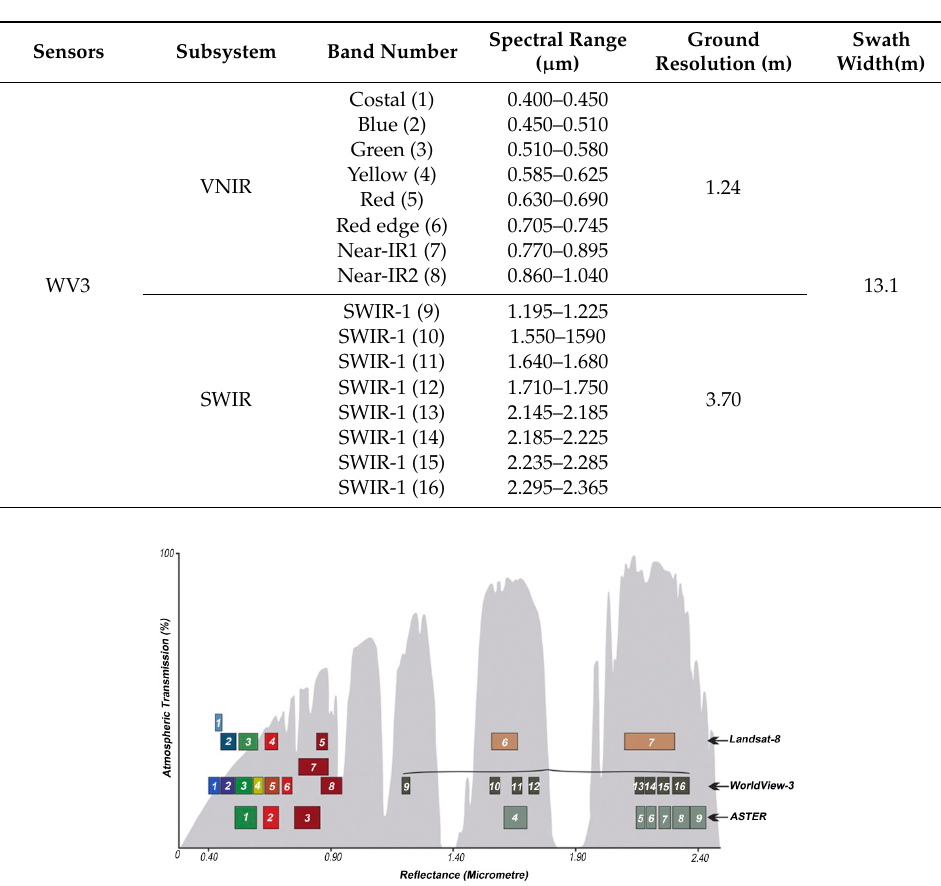
Figure 2. Comparison of the spectral bands of WV-3 with Landsat-8 and ASTER in the visible and near-infrared (VNIR) and shortwave infrared (SWIR) regions [46]. near-infrared (VNIR) and shortwave infrared (SWIR) regions